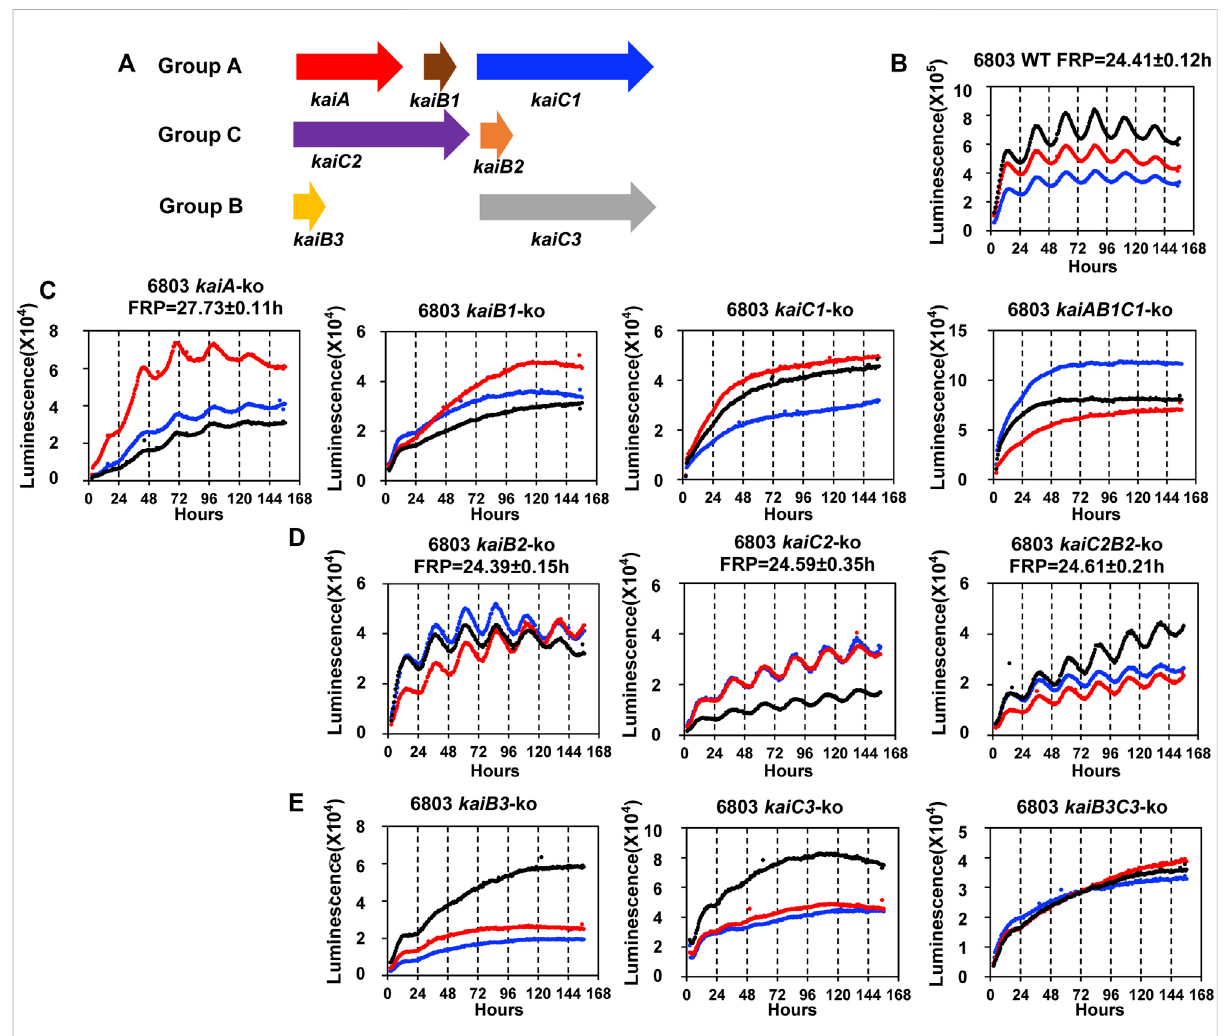
FIGURE 2 The rhythmicity of Synechocystis sp . PCC 6803 WT and kai null mutants on agar medium harboring the P psbA Ah ::luxAB reporter in LL . (A) . Schematic diagram of the three sets of kai genes in Synechocystis . The kaiA , kaiB1 and kaiC1 genes are localized together on the chromosome as a clock gene cluster, and kaiC1 belongs to GroupA that includes only kaiC s from cyanobacteria (Aoki & Onai, 2009). The kaiC2 and kaiB2 genes also localize together as a separate cluster, and kaiC2 belongs to GroupC which includes kaiC homologs from Archaea and Proteobacteria. The kaiB3 and kaiC3 localize separately on the chromosome, and kaiC3 belongs to GroupB which includes kaiC homologs from cyanobacteria, Proteobacteria and Chloro fl exi (Aoki & Onai, 2009). (B) . The rhythmicity of WT Synechocystis colonies in LL as monitored with the Kondotron. The free-running period (FRP) of WT in this experiment was 24.41 ± .12 h ( n = 3). Three representative colonies are shown. (C) . GroupA null mutants: expression patterns of kaiA-ko , kaiB1-ko , kaiC1-ko , kaiAB1C1-ko strains. All these null mutants were arhythmic except kaiA-ko , which expressed a reduced amplitude and long free-running period. (D) . GroupC null mutants: all three null mutants ( kaiB2-ko , kaiC2-ko and kaiC2B2-ko ) were rhythmicwiththefree-runningperiodsindicatedonthepanels. (E) .GroupBnullmutants:Allthreenullmutants( kaiB3-ko , kaiC3-ko and kaiB3C3-ko ) were arhythmic. Three representative traces are shown in each panel. FRP = free-running